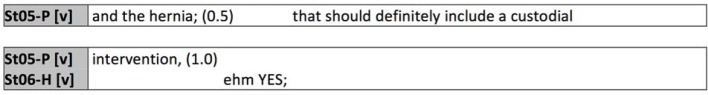
Distribution of tasks by naming the profession as an adjective